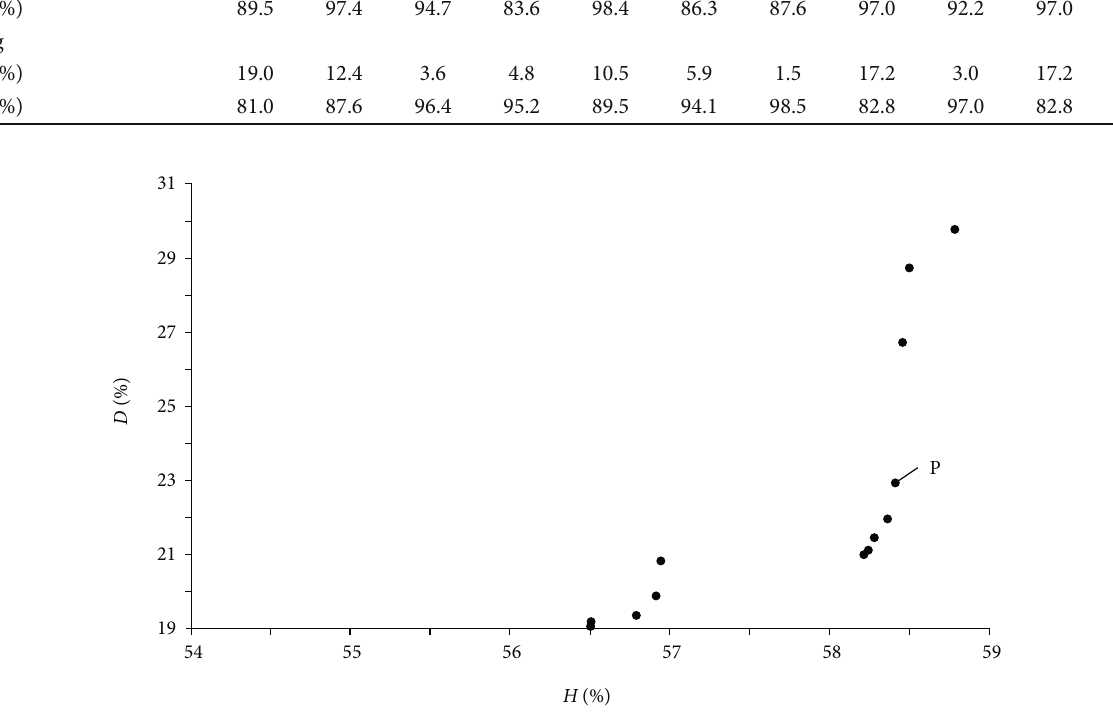
Figure 11: Pareto